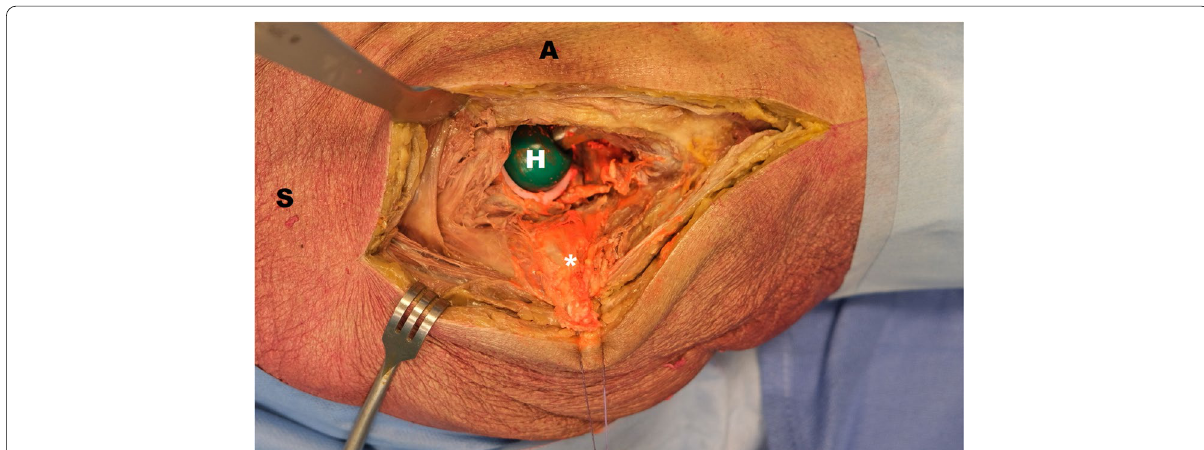
Fig. 3 One-step exchange using a posterolateral approach. Retracting the external rotators and posterior capsule reveals the infected THA. S